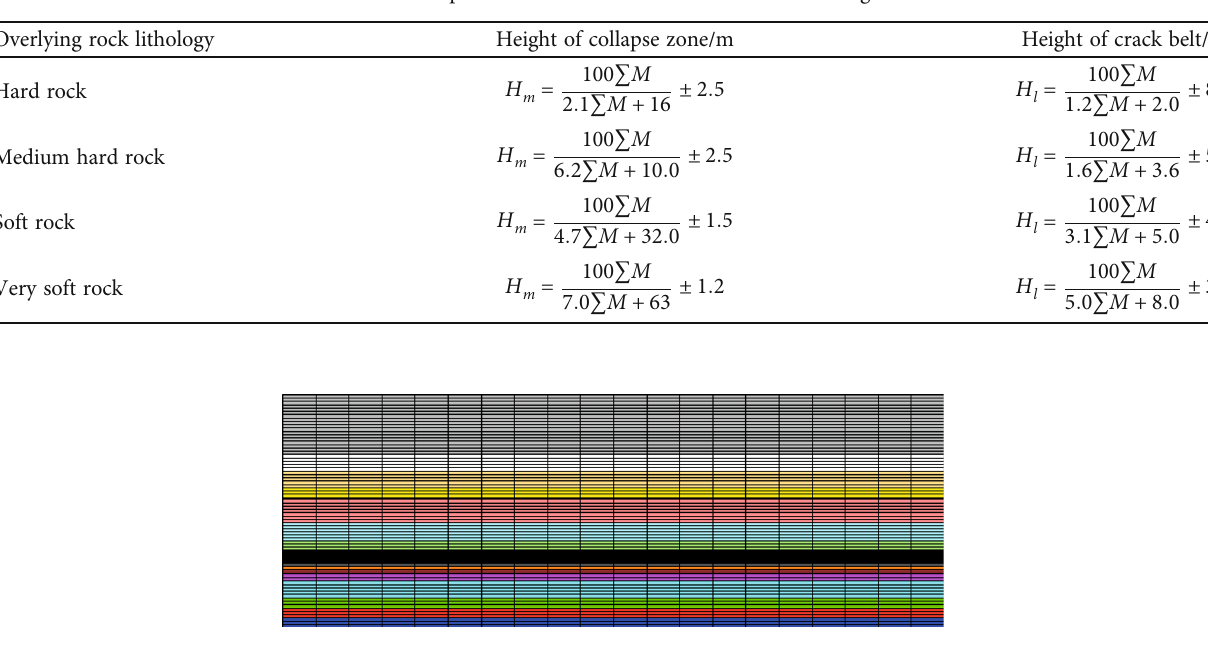
Table 1: Empirical calculation formula for three-band height.